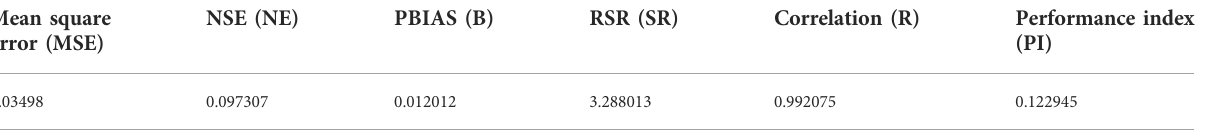
TABLE 7 Performance index of multiple linear regression